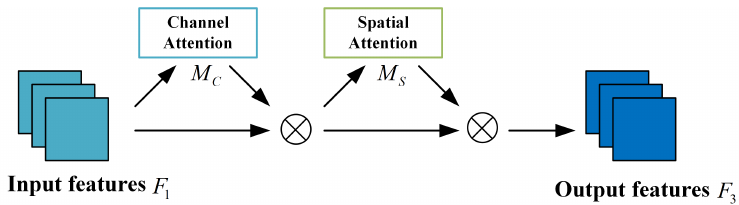
Figure 5. The overview of GAM.